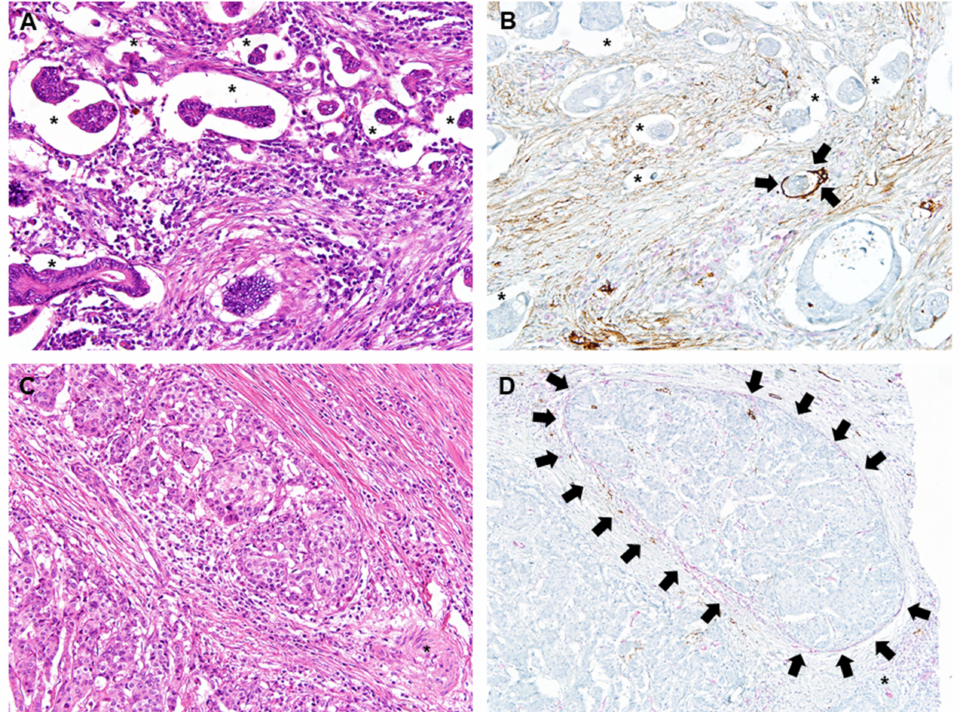
Figure 2. Representative images of venous and lymphatic invasion with original H&E staining and dual CD31-D2-40 immunolabeling. ( A ) Identifying lymphatic or venous invasion on H&E staining is extremely difficult due to retraction artifact (asterisks) making a space surrounding the cancer cells. ( B ) Dual CD31 (magenta)-D2-40 (brown) immunolabeling highlights cancer cell infiltration in lymphatic space (arrows) among numerous retraction artifacts (asterisks). ( C ) Identifying venous invasion on H&E (magenta)-D2-40 (brown) immunolabeling highlights venous invasion (arrows) of cancer cells. Venous endothelial cells show magenta color (CD31 labeling). Magnification of all images, ×